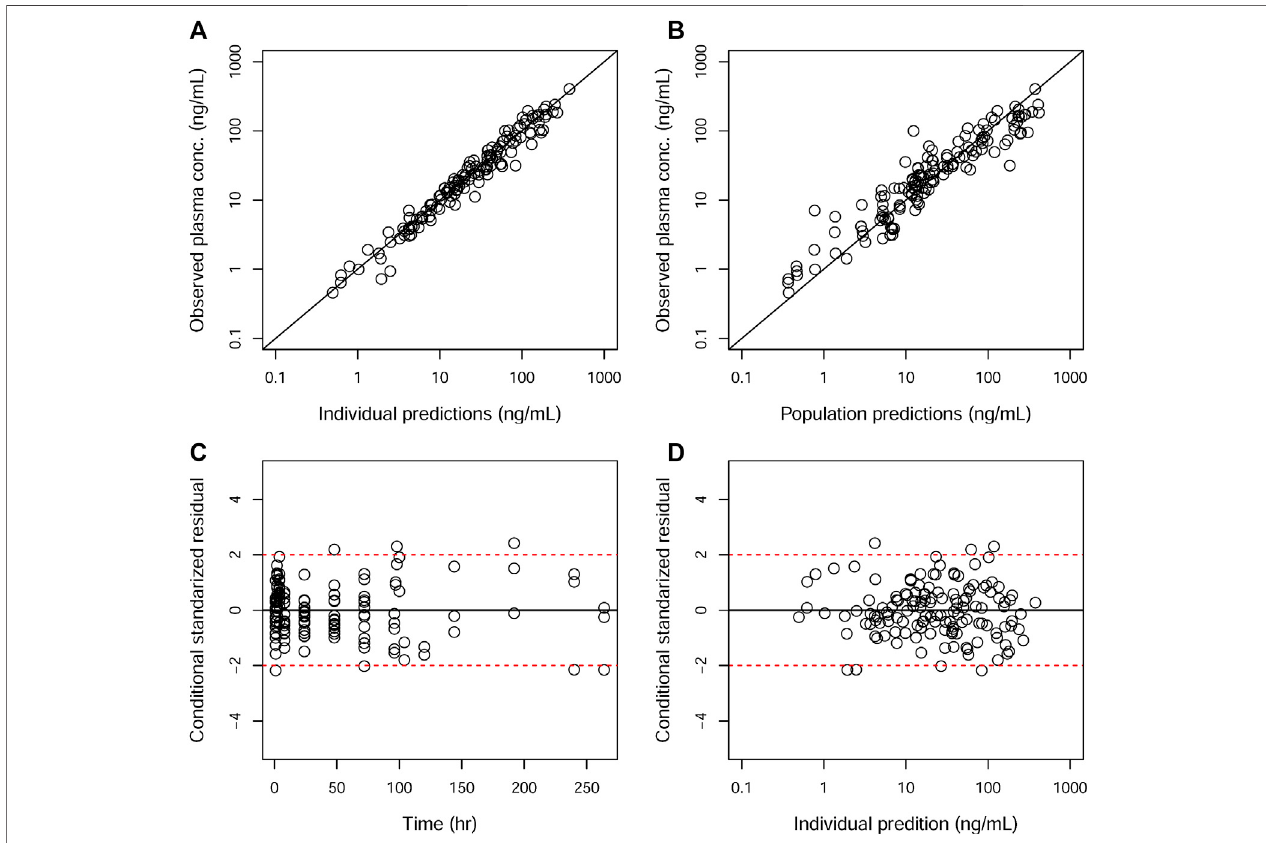
FIGURE3 | Goodness-of- fi t plotsof theplasma for the fi nal model. The hollowcircles representthe observed data from individual monkeys. The black diagonal (A and B) and horizontal lines (C and D) are the lines of identity and zero lines, respectively. The dashed lines in the bottom panel are the conditional standardized residual equal ±